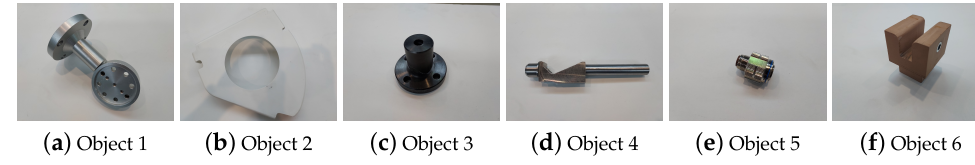
Figure 5. Set of six industrial objects selected to appear in our dataset. from the UE4. RGB and semantic segmentation images are 8-bit images. Depth image is a 16-bit image measured in